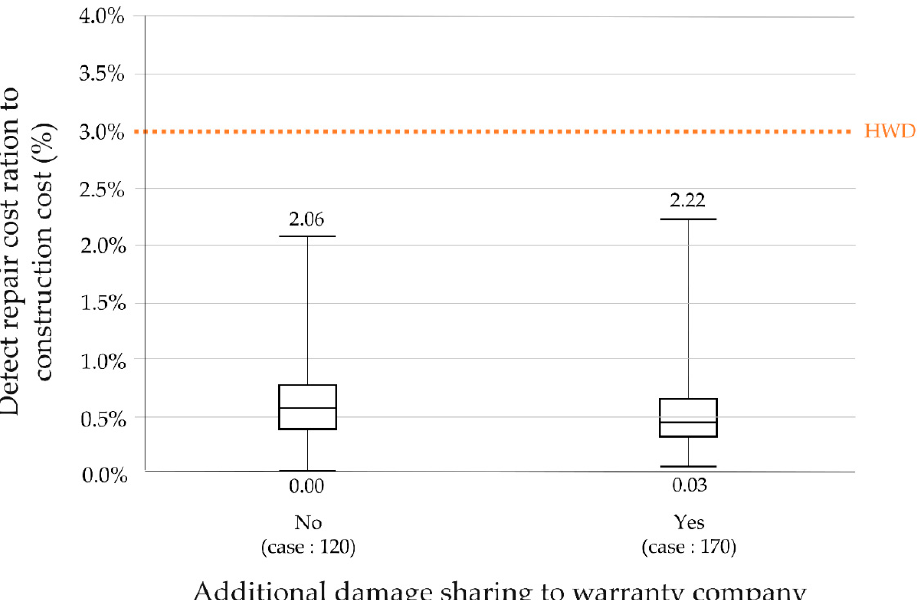
Figure 13. Comparison of additional damage sharing by the warranty company.